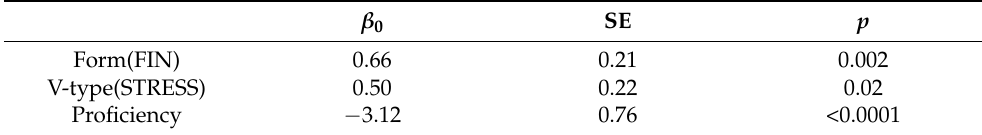
Table 7. Model parameters for non-matching items (Form, V-type and Proficiency).